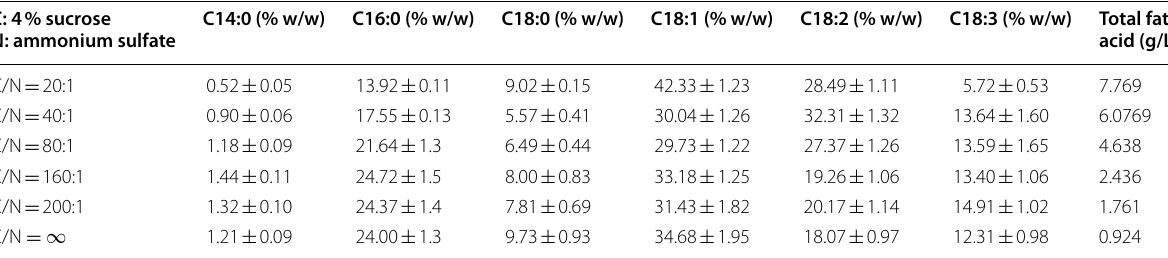
Table 1 Changes of fatty acid content of R-ZL2 in different C/N ratios